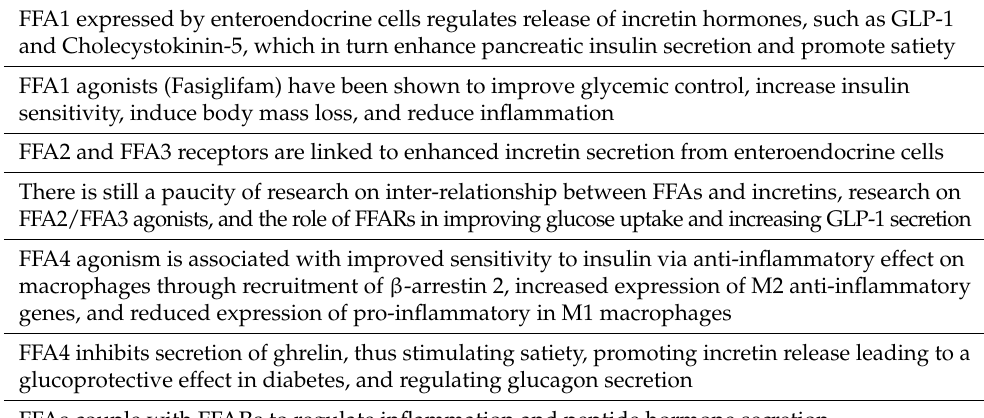
Table 1. Effects of Free Fatty Acids on Glucose and Incretin Metabolism. FFA1 expressed by enteroendocrine cells regulates release of incretin hormones, such as GLP-1 and Cholecystokinin-5, which in turn enhance pancreatic insulin secretion and promote satiety FFA1 agonists (Fasiglifam) have been shown to improve glycemic control, increase insulin sensitivity, induce body mass loss, and reduce inflammation FFA2 and FFA3 receptors are linked to enhanced incretin secretion from enteroendocrine cells There is still a paucity of research on inter-relationship between FFAs and incretins, research on FFA2/FFA3 agonists, and the role of FFARs in improving glucose uptake and increasing GLP-1 secretion FFA4 agonism is associated with improved sensitivity to insulin via anti-inflammatory effect on macrophages through recruitment of β -arrestin 2, increased expression of M2 anti-inflammatory genes, and reduced expression of pro-inflammatory in M1 macrophages FFA4 inhibits secretion of ghrelin, thus stimulating satiety, promoting incretin release leading to a glucoprotective effect in diabetes, and regulating glucagon secretion FFAs couple with FFARs to regulate inflammation and peptide hormone secretion FFA: Free Fatty Acids, FFARs: Free Fatty Acid Receptors, GLP-1: Glucagon-Like